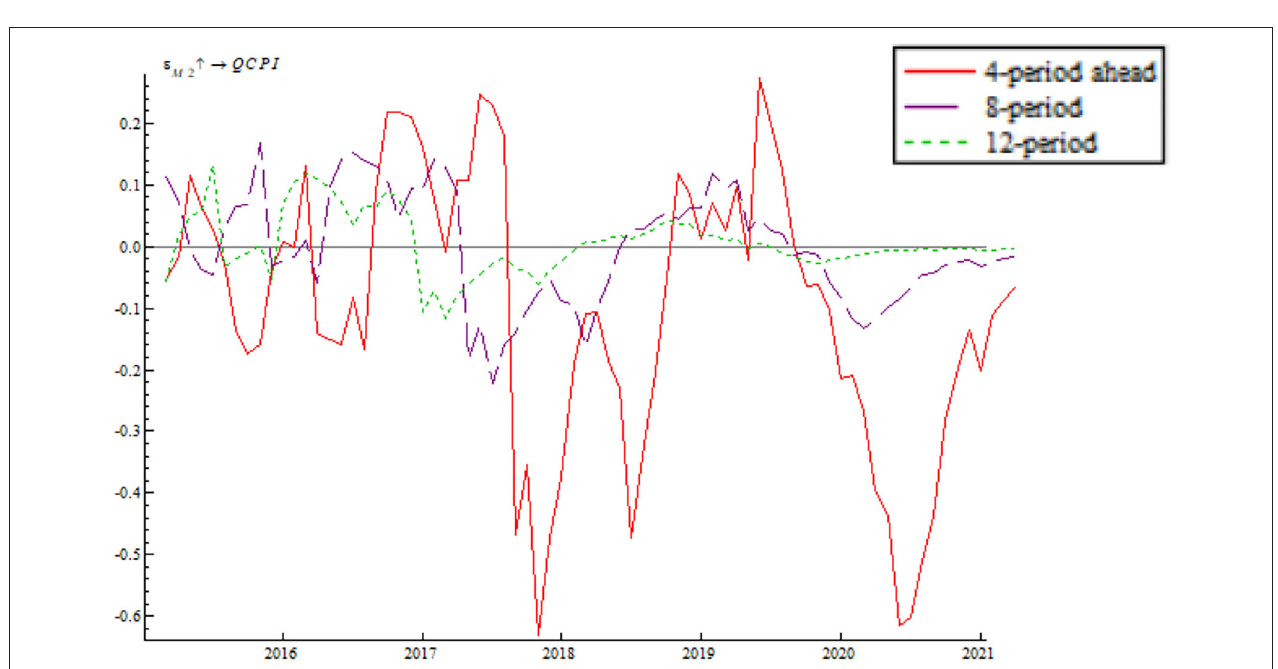
FIGURE 9 | Shock of the quantitative monetary policy instrument on inflationary